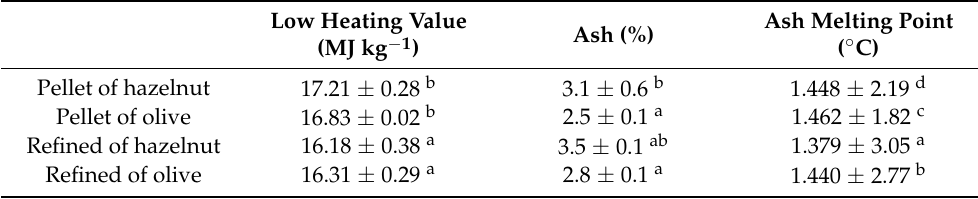
Table 4. Low heating value (Kruskal–Wallis: p < 0.01), ash content (Welch F-test: p < 0.001) and ash melting point (One-Way Anova: p < 0.001) of the material refined constituents for pellet. Numbers followed by different letters are statistically different ( p <